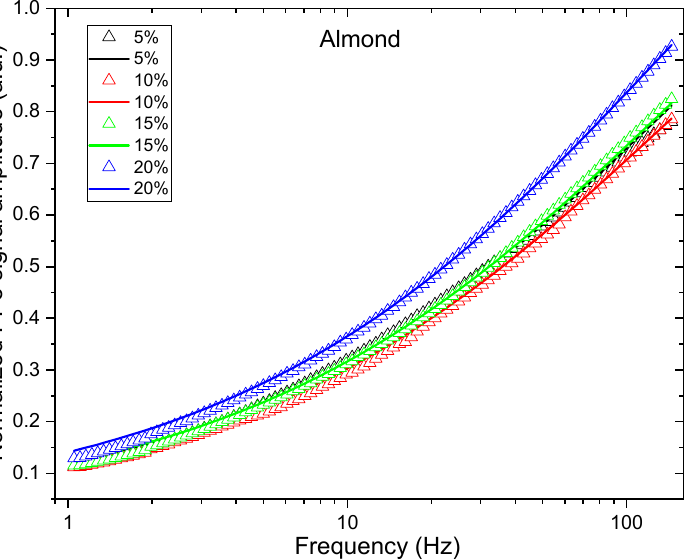
Figure 3. Experimental IPPE signal amplitude with AO/MO mixtures as the sample; triangles represent the experimental points, and solid lines are the best fitting of Equation (1) to the experimental points.